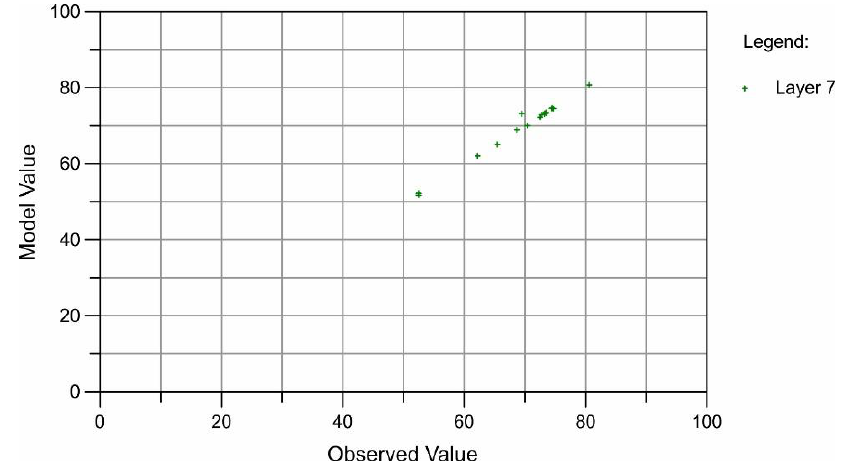
Figure 14. Calibration graph of recorded and simulated piezometric head (September 2014).